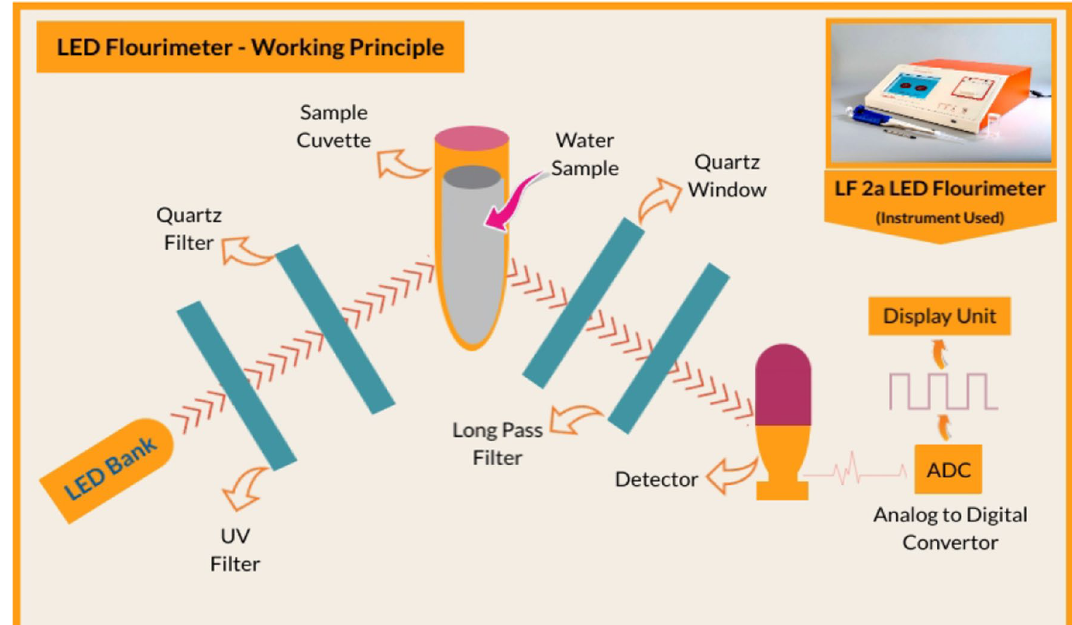
Fig. 4 LED fluorimeter working